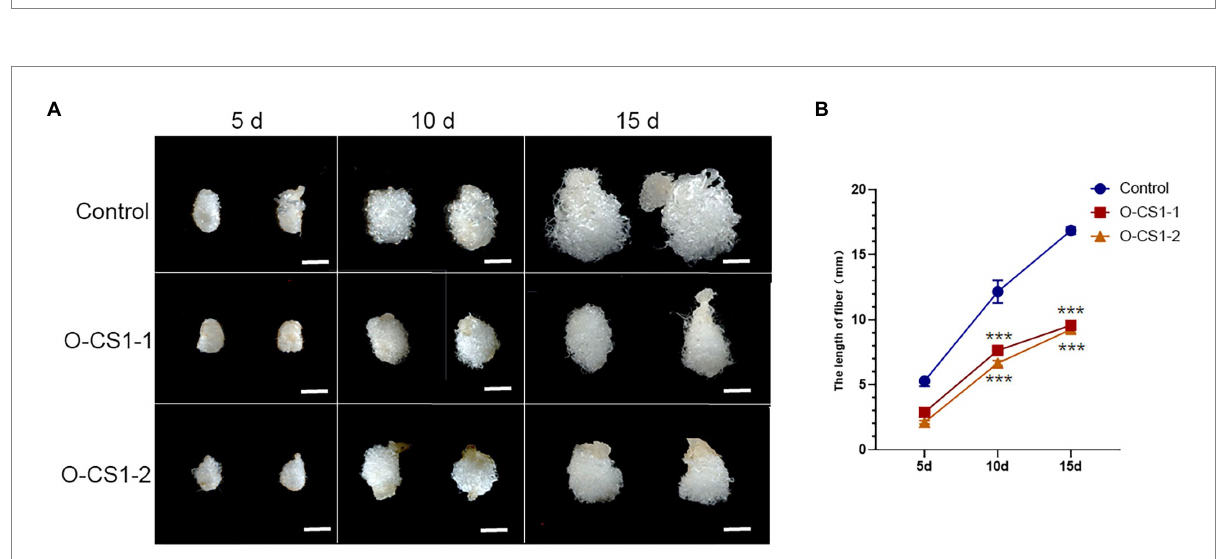
FIGURE 6 Cotton fiber growth in the ovule culture system in vitro . (A) The ovules of control and transgenic cotton plants grew in the ovule culture system in vitro ; (B) The fiber length of cultured fiber cells in vitro . Control: Wild-type cotton; O-CS1-1and O-CS1-2: The transgenic cotton line 1# and 2# overexpressing GhCS1 cotton. Data underwent a Student’s t -test: *** indicate p < 0.001, respectively, vs. the wild-type. Bar = 4